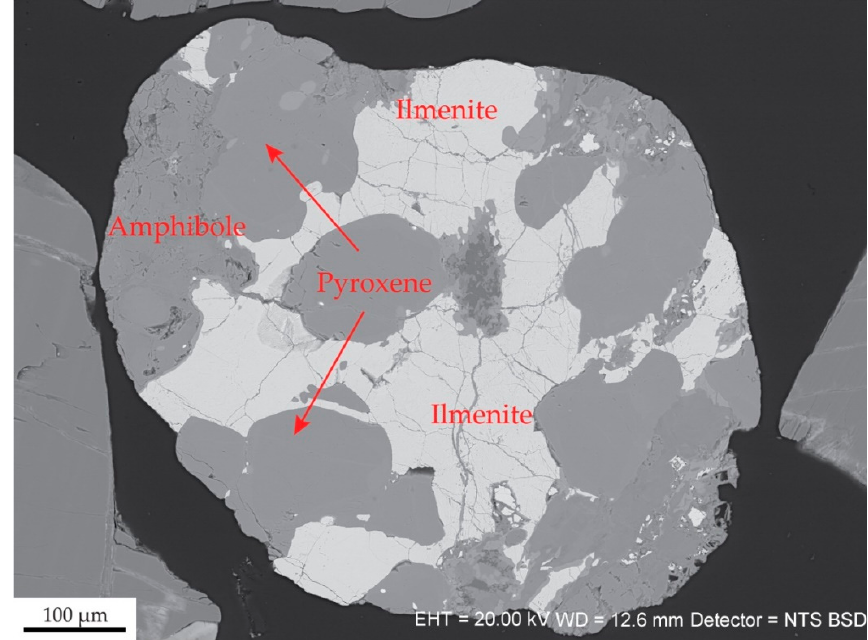
Figure 9. Pyroxene with paragenesis amphibole and ilmenite. SEM-BSE